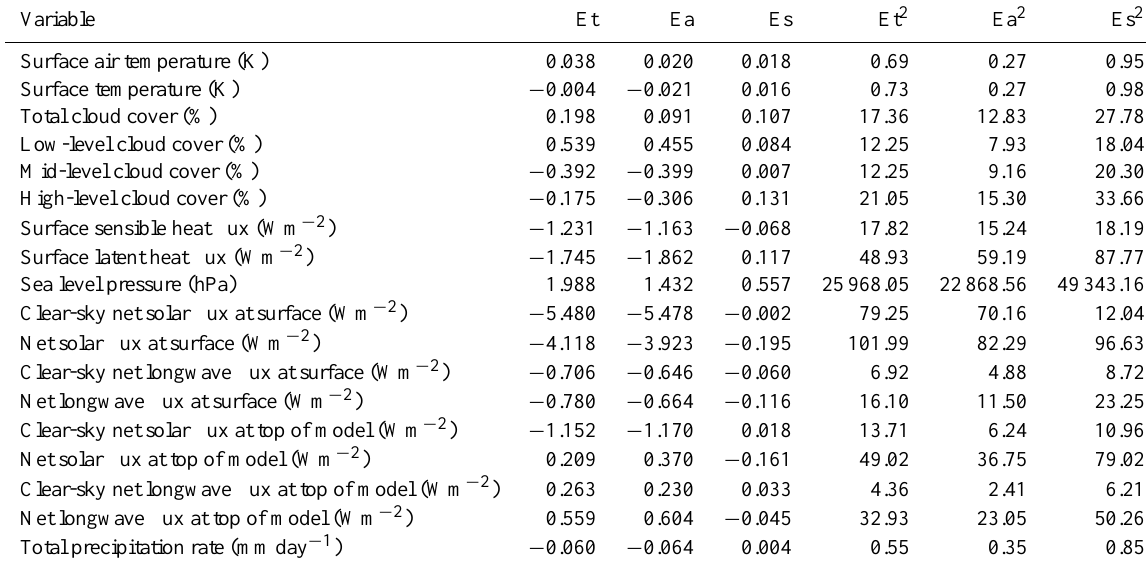
Table 3. The annual mean global average Et, Ea, Es, Et 2 , Ea 2 , and Es 2 for a list of climate variables. Units in parentheses are for Et, Ea, and Es analysis. Corresponding unit for Et 2 (or Ea 2 , Es 2 ) is square of Et (or Ea, Es) unit.